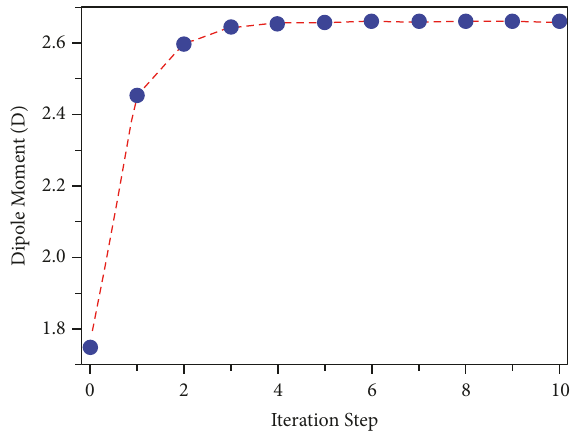
Figure 13: Evolution of values of the dipole moment of the EPAF crystal with the respective iteration